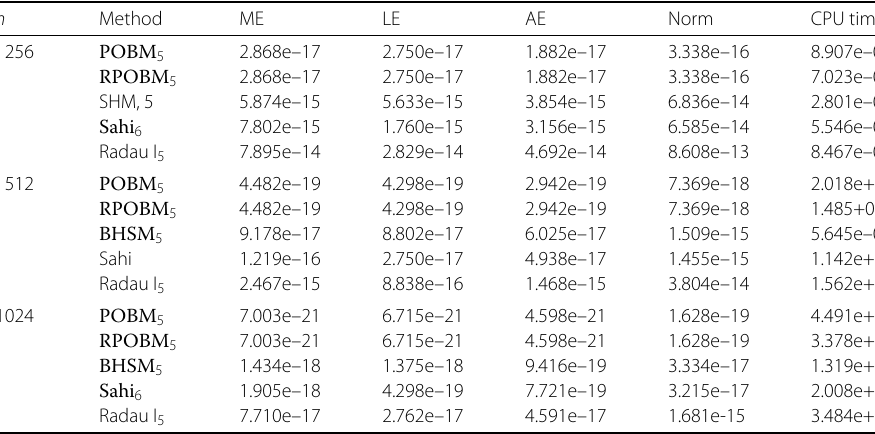
Table 2 Comparison of the methods under consideration on the basis of absolute errors and CPU time for Problem 2 with different number of steps ( n )